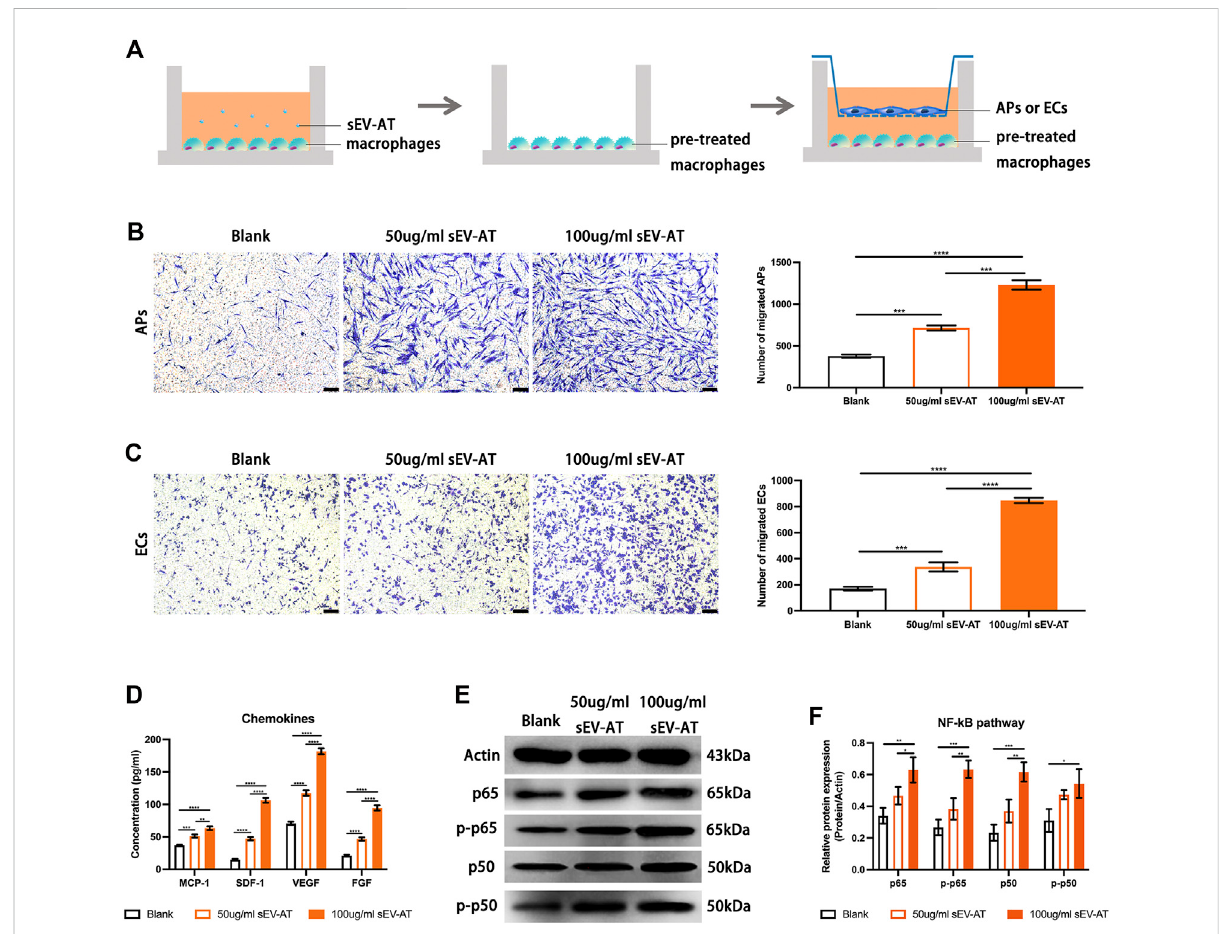
FIGURE 7 The chemoattraction ability of macrophages induced by sEV-AT in vitro . (A) Schematic view of the experimental operation process. Macrophageswereseededinthelowerlayerandculturedwith0,50,and100 μ g/mlsEV-ATfor6 h,thentheculturemediumwasremoved,andAPs or ECs were seeded in the upper layer to set up a co-culture system. (B) Representative images of migrated APs. Scale bar = 200 µm. Migrated APs per fi eld of view (scale bar = 200 µm) were analyzed (n = 3). (C) Representative images of migrated ECs. Scale bar = 200 µm. Migrated ECs per fi eldofview (scalebar=200 µm)wereanalyzed (n=3). (D) Theconcentrationofchemokines(SDF-1,MCP-1,VEGF,andFGF) intheculturemedium was analyzed (n = 3) by ELISA. (E) Western blot and (F) semi-quanti fi cation of the expression of NF-kB signaling pathway-related proteins (p50,